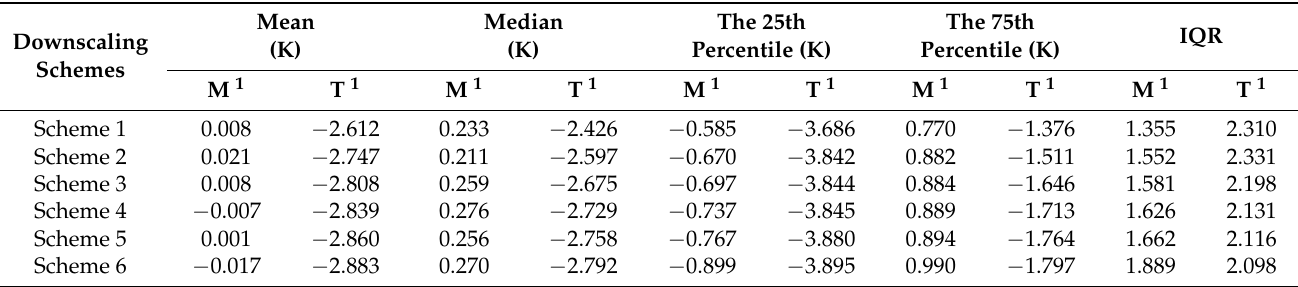
Figure 9. LST error distribution boxplots of the MFGWML and TsHARP models for the six downscaling schemes: ( a ) Scheme 1, ( b ) Scheme 2, ( c ) Scheme 3, ( d ) Scheme 4, ( e ) Scheme 5, and ( f ) Scheme 6. The black line indicates the median value. The blue and purple boxes indicate the percentiles for the MFGWML and TsHARP models, respectively. The solid red dots indicate outliers. Table 7. Statistical indicators of LST error distribution in MFGWML and TsHARP for the six downscaling schemes performed in the entire city of Beijing (excluding water regions).